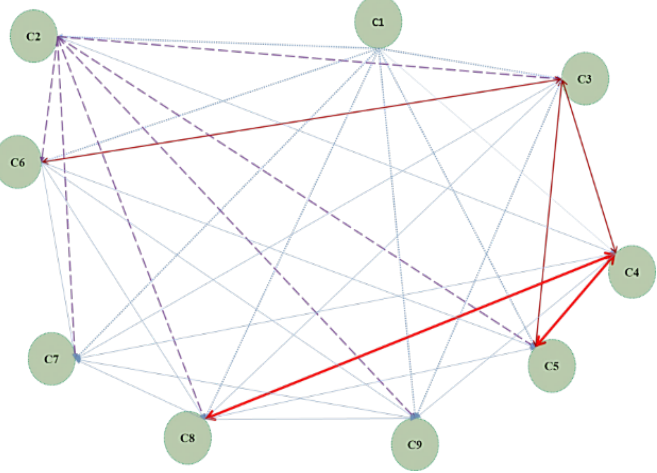
Fig. 2. The interrelationships between the